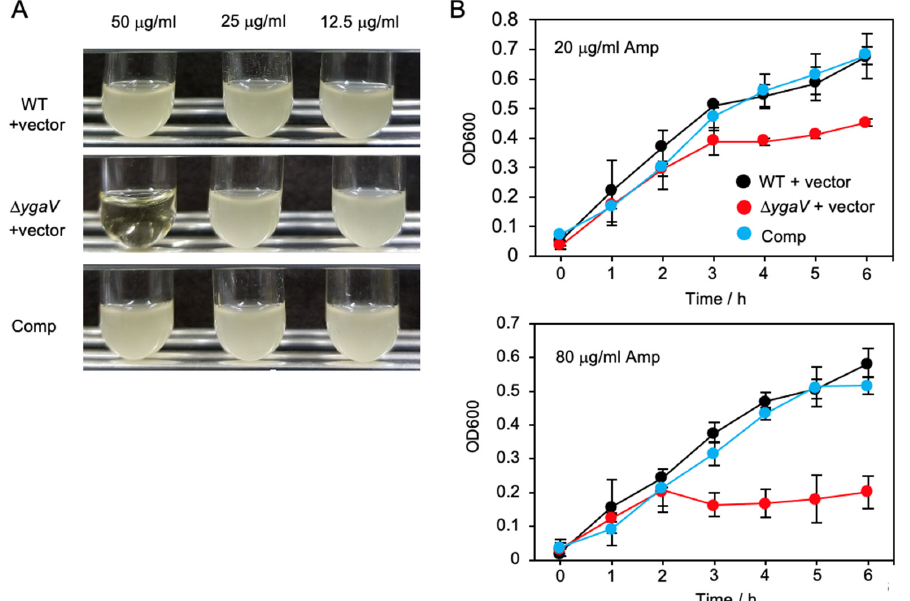
Figure 10. Inhibited growth of the ygaV mutant by Amp: ( A ) The Amp ‐ resistance empty pPAB404 vector was introduced into WT and ygaV mutants. The complementing strain of ygaV mutant (Comp) harbors the pPAB404 encoding ygaV . Colonies of each strain on agar ‐ solidified plates containing 50 μ g ml − 1 Amp were picked, placed in liquid medium containing 50, 25 and 12.5 μ g ml − 1 Amp, and then incubated for 16 h; ( B ) Overnight cultures of the three strains shown in ( A ) in liquid medium containing 20 μ g ml − 1 Amp, were diluted 20 ‐ times with fresh LB medium containing 80 and 20 μ g ml − 1 Amp, and then growth of the strains was monitored by measuring optical density at 600 nm (OD600).